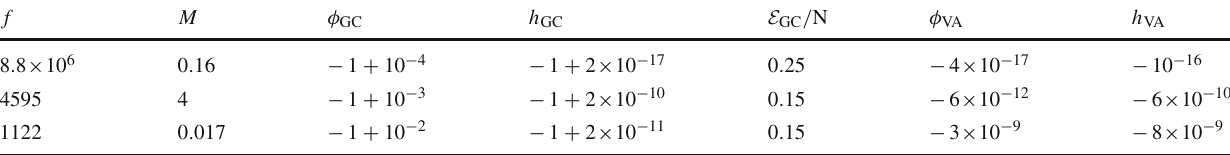
Table 2 Few instances of numerical solutions for stationary points of (4.7) with (cid:5) = 1, but without making any approximation at the level of the effective potential. The numerical solutions approach the analytic solutions as we go closer to the parametric limits that allow our approx- imations. Since the vacuum energy at the VA point is always in very